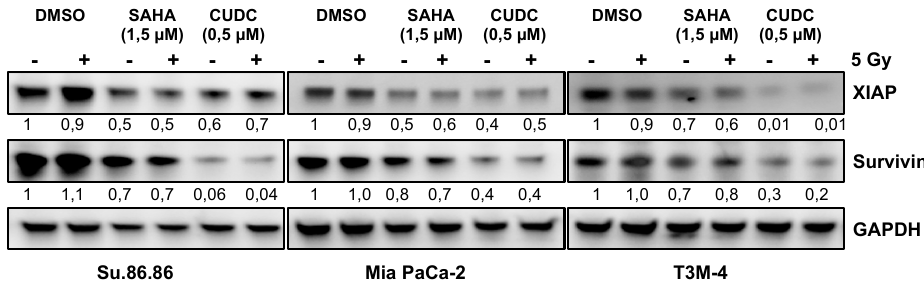
Figure 6. Expression of antiapoptotic factors XIAP and survivin is reduced after combined HDAC inhibitor / radiation treatment. A representative western blot (out of 3 biological replicates) of survivin and XIAP protein expression after treatment with CUDC-1 and / or irradiation. n -Fold change compared to non-irradiated control is indicated. + irradiated with 5 Gy, − non-irradiated